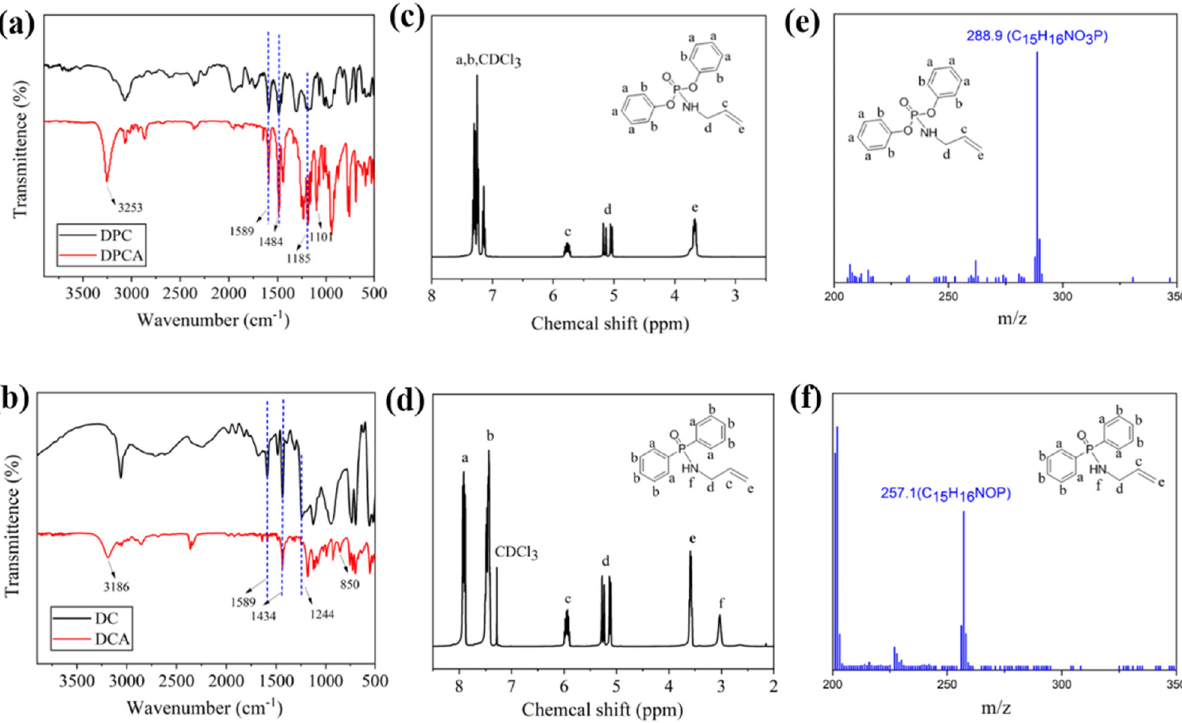
Figure 1: ( a ) and ( b ) FTIR spectra of DPCA and DCA. ( c ) and ( d ) 1 H NMR spectra of DPCA and DCA in CDCl 3 . ( e ) and ( f ) MS spectra of DPCA and